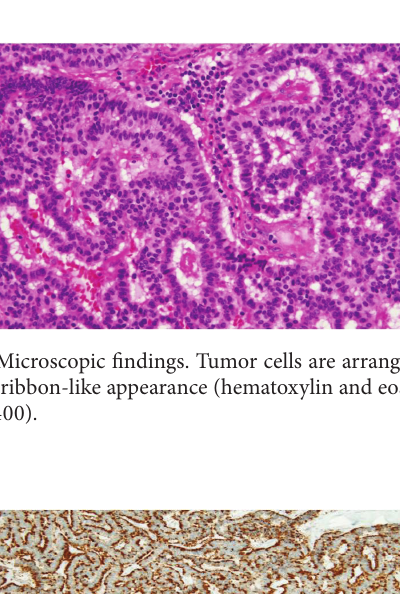
Figure 1: Abdominal computed tomography (CT).